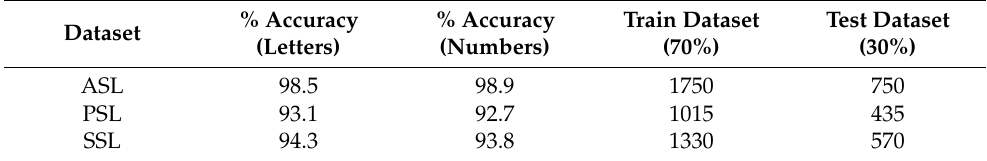
Table 3. Accuracy of